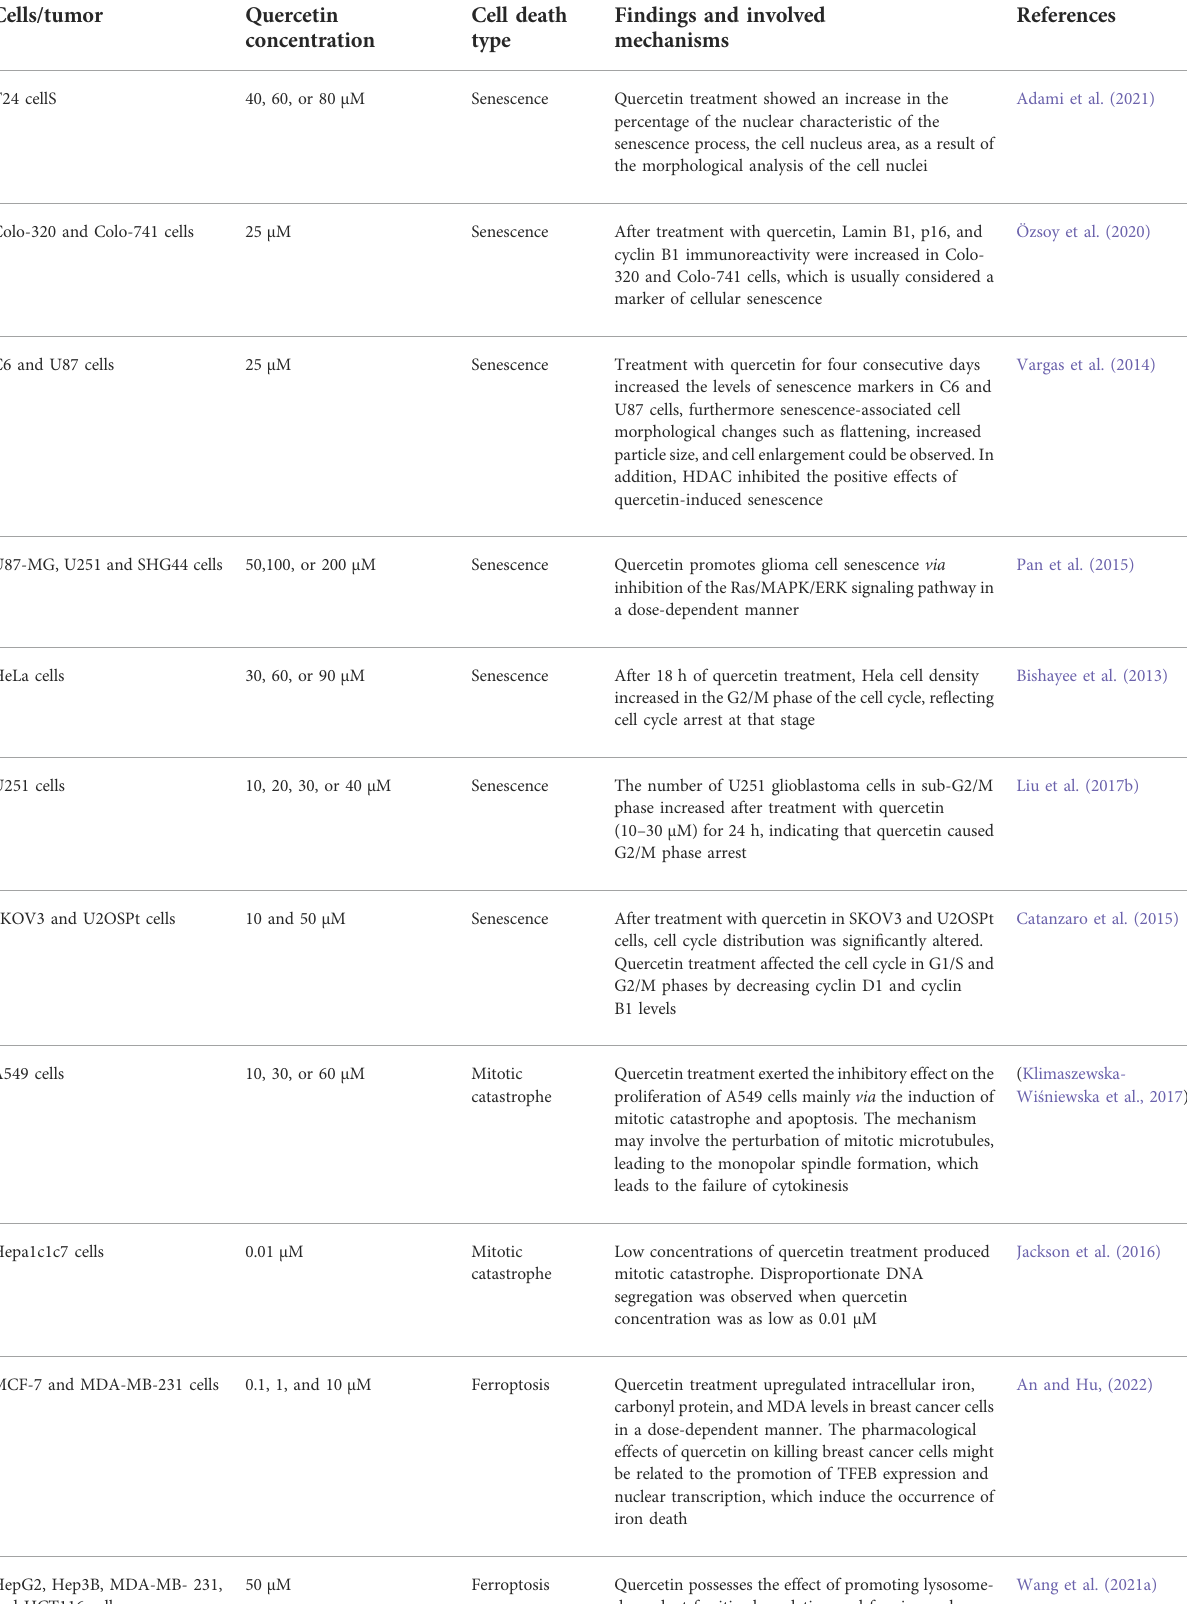
TABLE 2 Summarized mechanisms of non-apoptotic death of cancer cells following treatment with